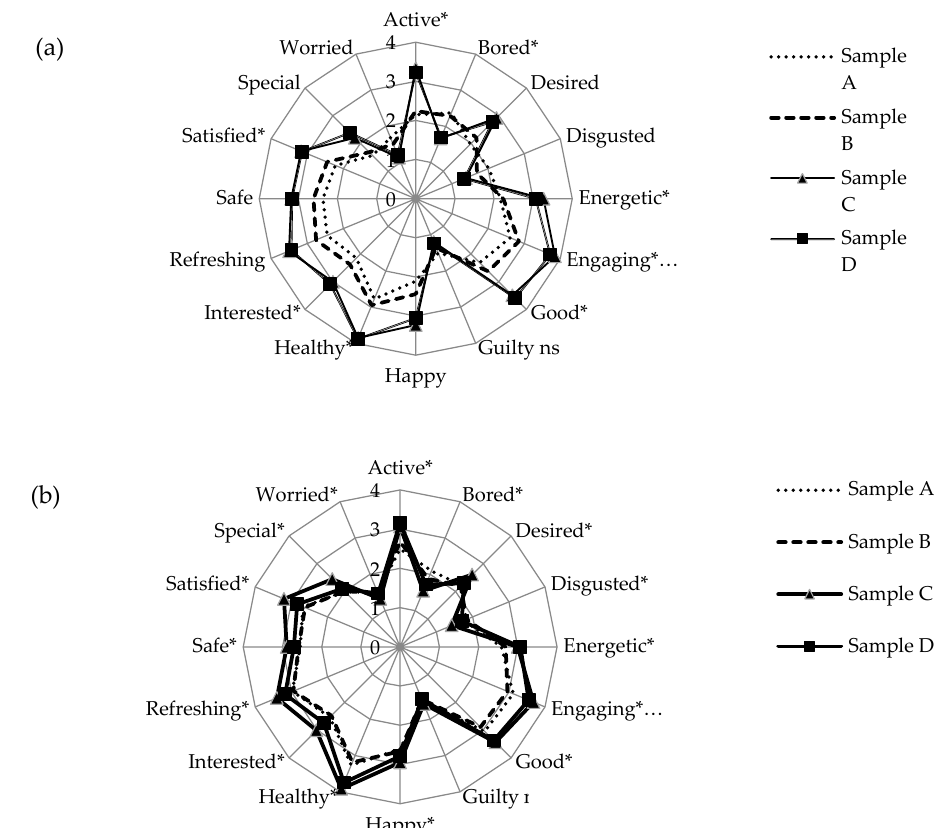
Figure 2. Mean emotion scores elicited by green color cues: ( a ) without product name and ( b ) with product name. * indicates significant difference among mean emotion scores ( P < 0.05). Refer to Table 3 for sample (A–D) image and description.